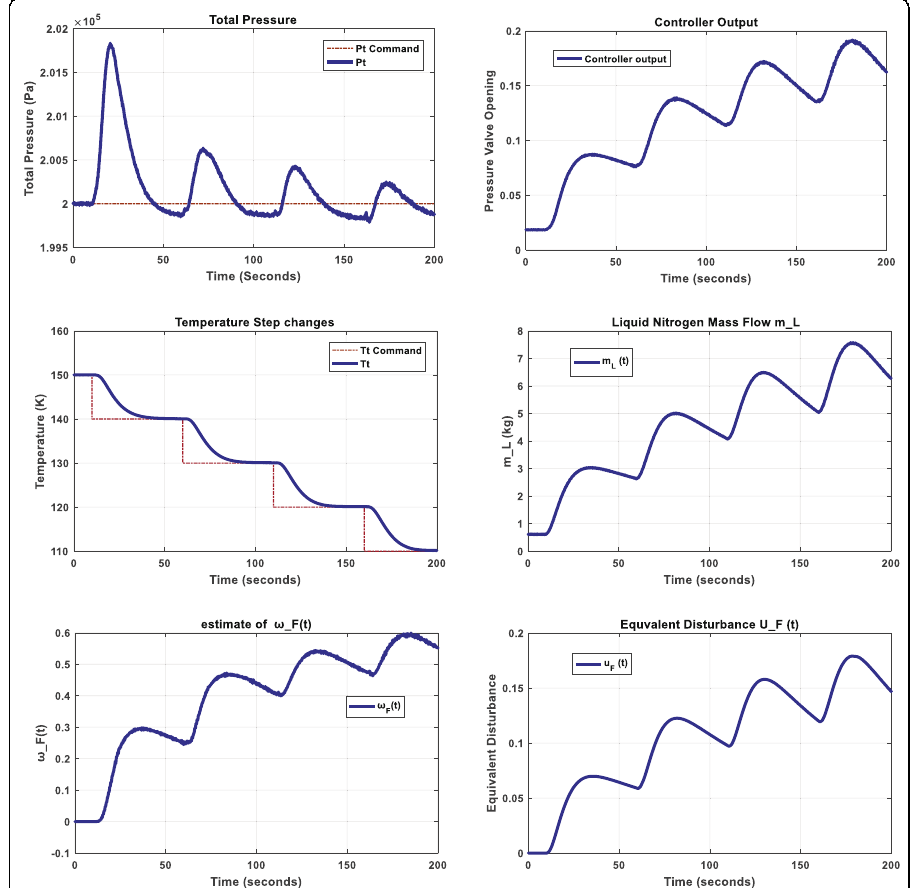
Fig. 5 Adaptive feedforward pressure